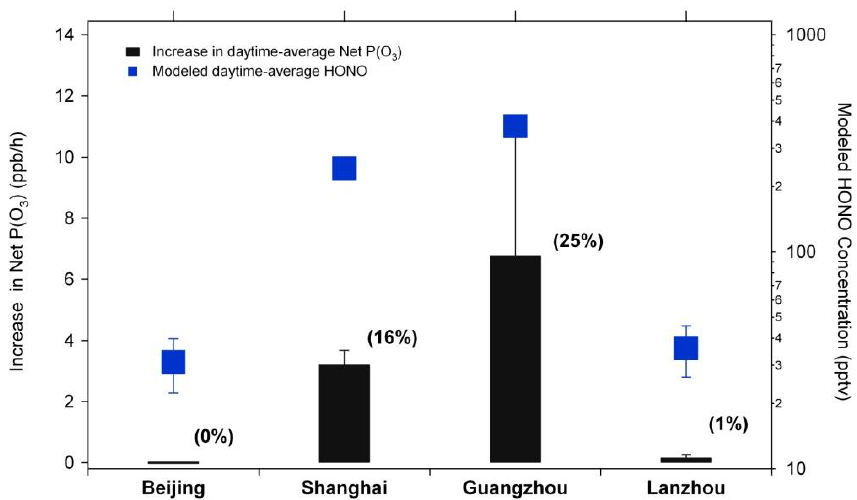
Figure 7. Average reductions in the daytime-average HO 2 concentrations and O 3 production rates by adjusting γ HO episodes at four cities. Also shown are the observed aerosol surface area concentrations (note that the data in Guangzhou were inferred from the measurements at a nearby station in Hong Kong). The error bars are standard deviations.